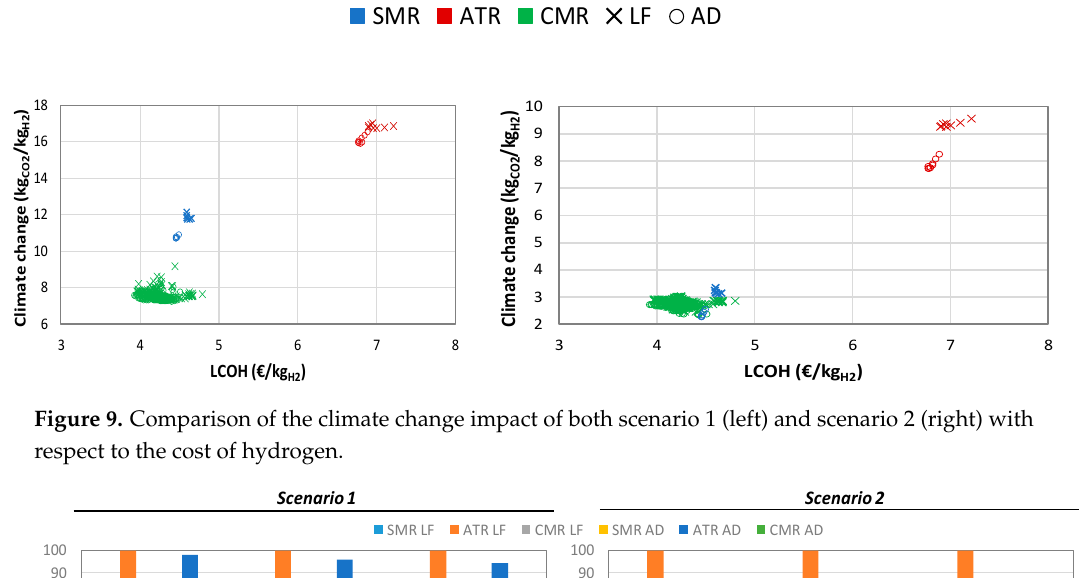
Figure 9. Comparison of the climate change impact of both scenario 1 (left) and scenario 2 (right) with respect to the cost of hydrogen.